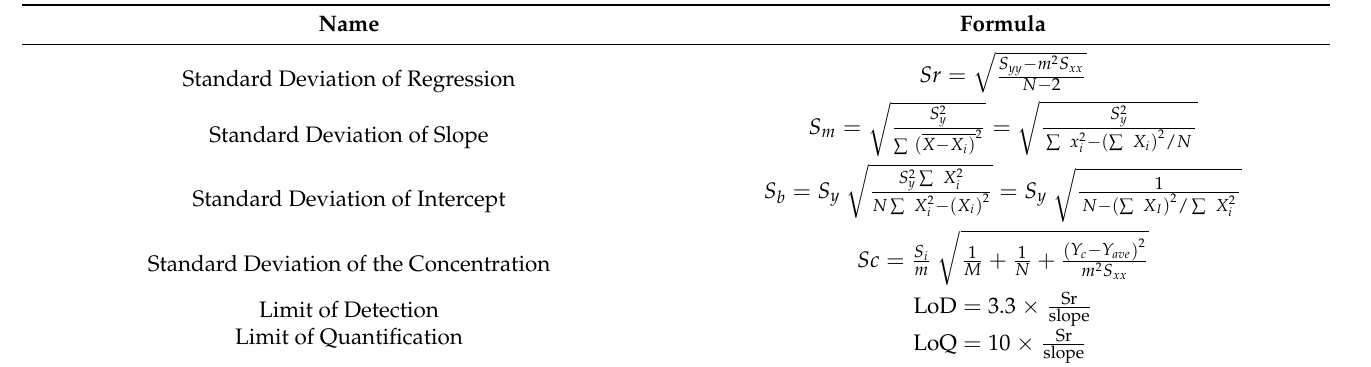
Table 2. Formula for uncertainty measurement.